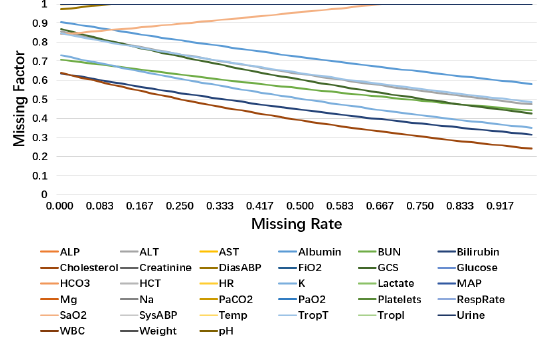
Figure 10. Learned missing factor of 33 variables in PhysioNet.